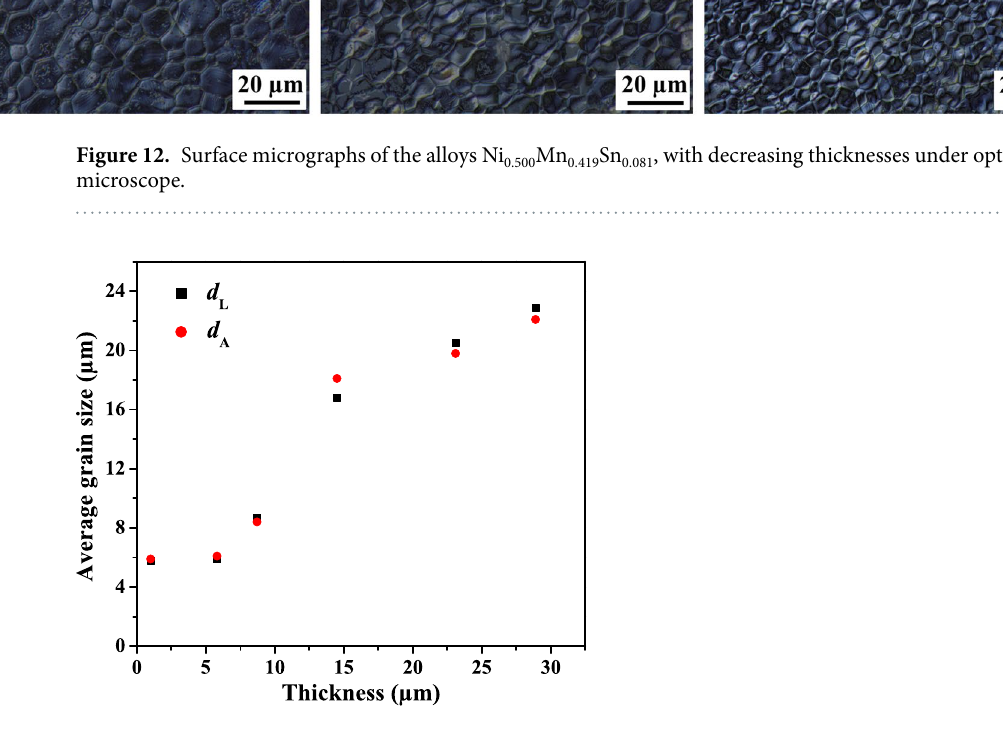
Figure 13. Grain sizes of different thickness alloys Ni 0.500 Mn 0.419 Sn 0.081 , based on intercept or areal, counting